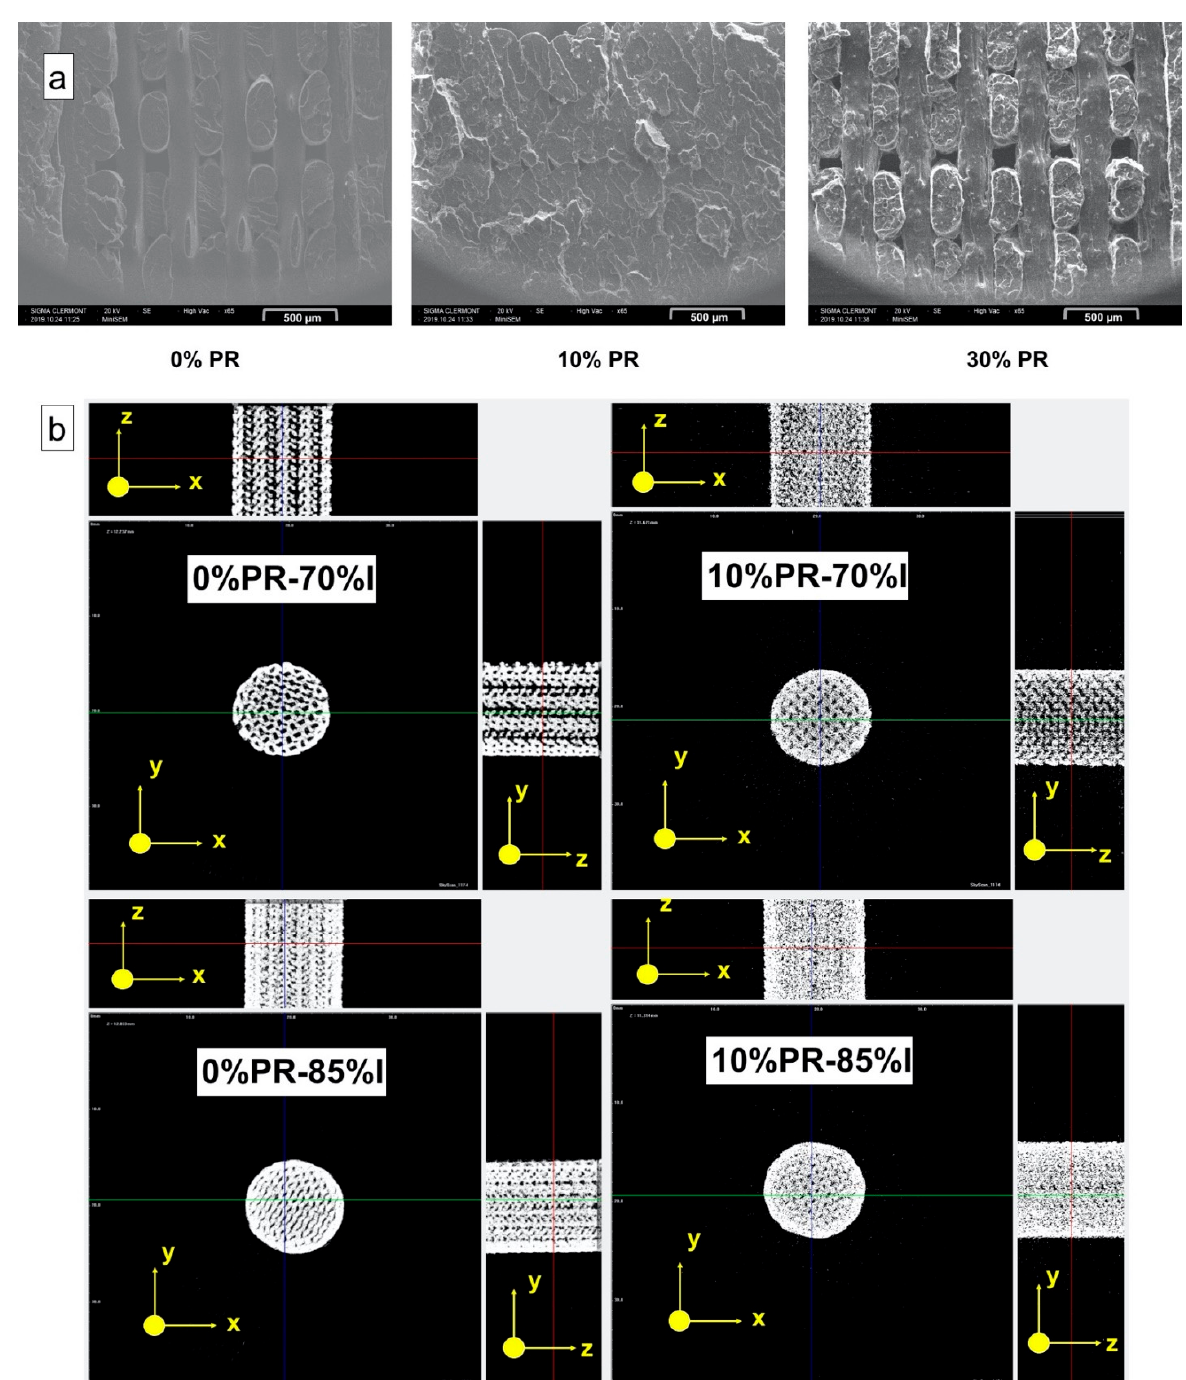
Figure 5. Scanning electron microscope (SEM) pictures of the fracture cross-section of the tensile specimens ( a ) and axonometric projections of the permeable part 3D printed at different ID percentages obtained with X-ray tomography ( b ).